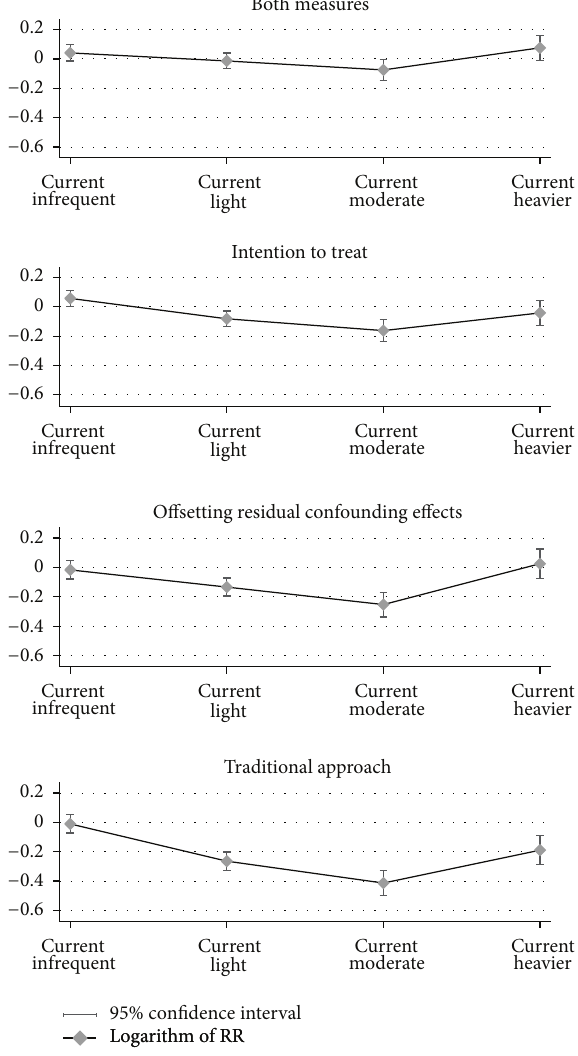
Figure 1: Comparison of alternative models for assessing the asso- ciation between health status and alcohol consumption: offsetting confounding effects and applying intention-to-treat analysis (RR: relative